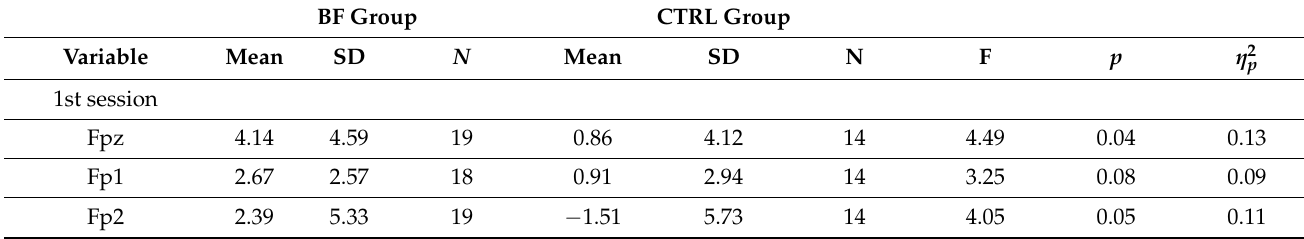
Table 3. Between-group differences in nirHEG percentage values during training sessions for each site and by